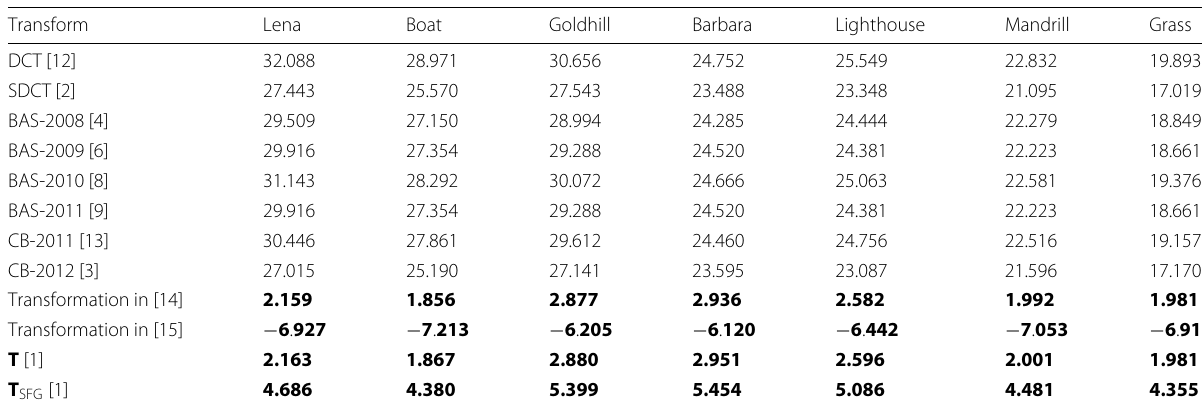
Table 3 PSNR of reconstructed images ( r = 10)